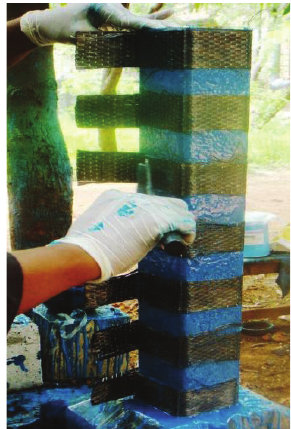
Figure 2: Squeezing of resin by steel roller.